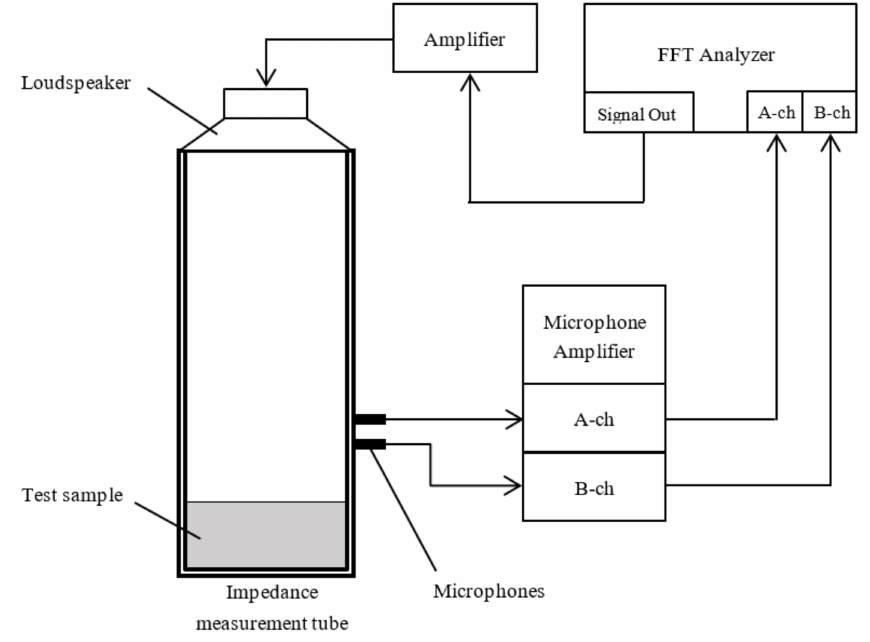
Figure 2. Two-microphone impedance tube for absorption coefficient